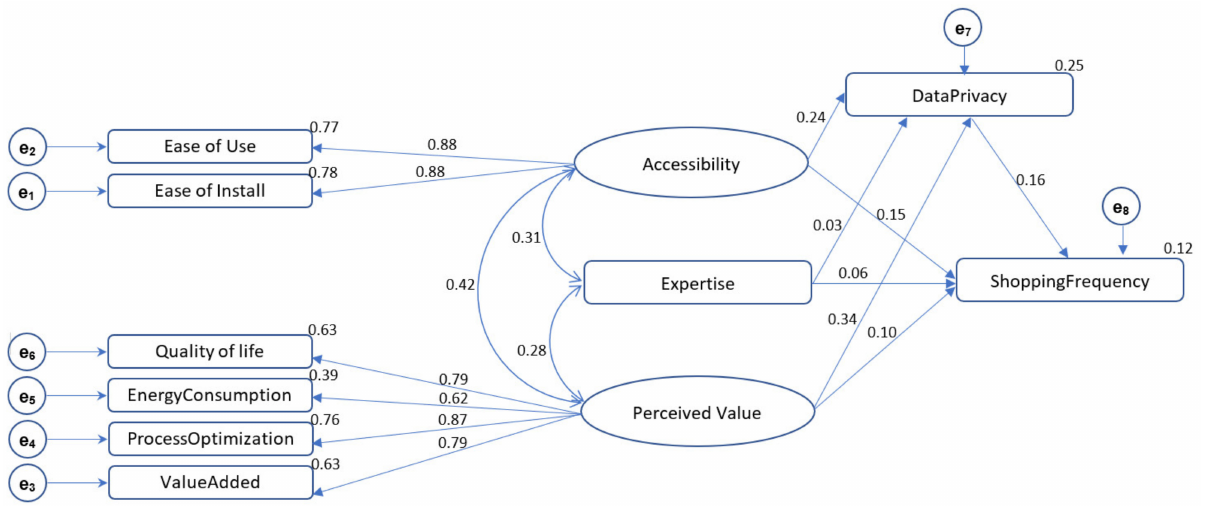
Figure 1. Validated conceptual framework. Source: Smart PLS 3 software report.